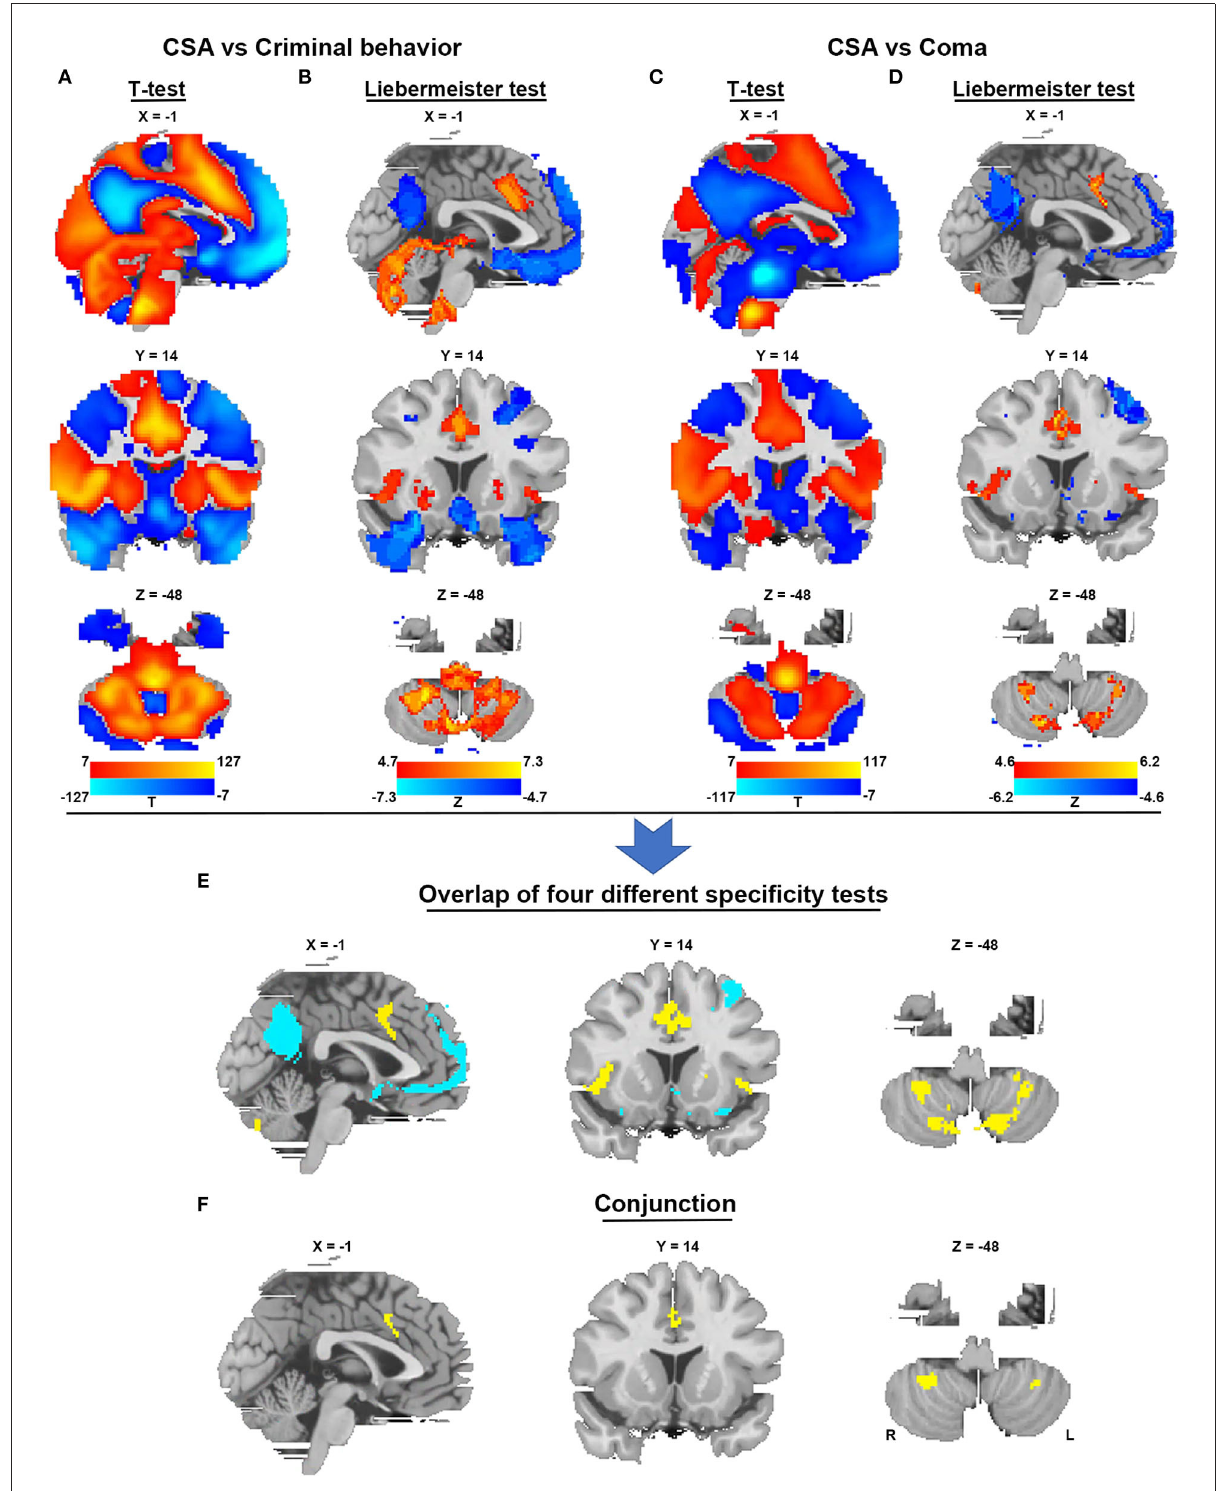
FIGURE4 Specificity and conjunction analysis. (A,B) Comparison of the network of CSA with the network of lesions causing criminal behavior using two-sample t -tests and the Liebermeister test. (C,D) Comparison of the network of CSA with the network of lesions causing coma using two-sample t -tests and the Liebermeister test. (E) Overlap of four different specificity tests to identify connections specific to lesions causing CSA relative to control lesions. (F) A conjunction analysis showed that regions in the middle cingulate gyrus and bilateral cerebellar posterior lobes were specific to lesions causing